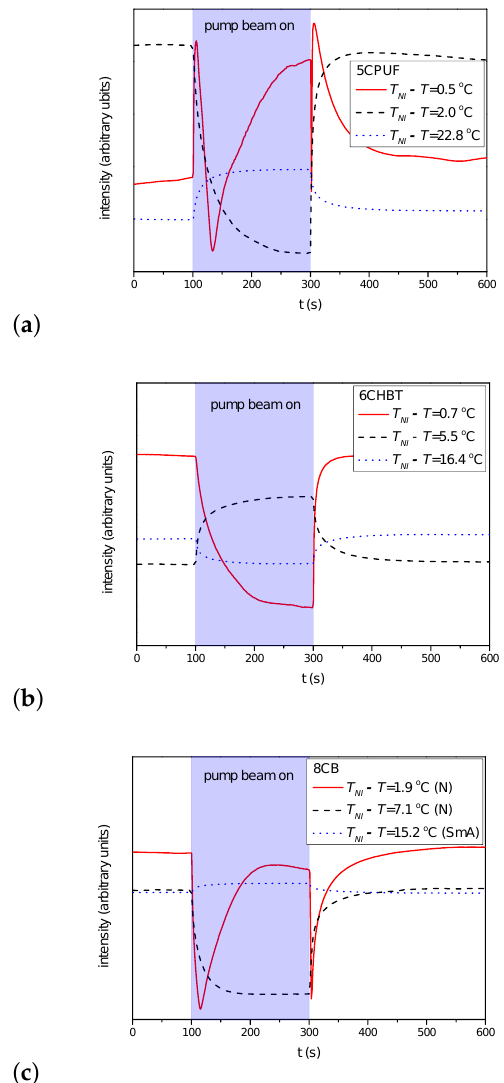
Figure 5. Temporal variation of the transmitted light intensity of the probe beam measured in cells with ( a ) 5CPUF, ( b ) 6CHBT, ( c ) 8CB at different temperatures, in the setup for detection of zenithal photoreorientation (pump beam polarization direction perpendicular to n , probe beam polarization direction encloses 45° with n